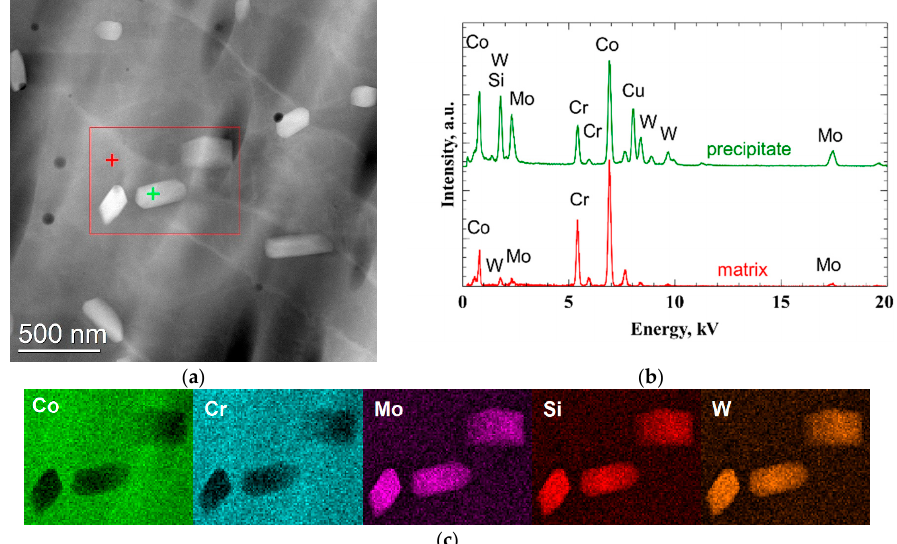
Figure 5. Chemical composition of the elongated shape precipitates. ( a ) STEM-HAADF image; ( b ) comparison of Energy Dispersive (EDS) spectra at the points indicated in (a ); ( c ) maps of Co, Cr, Mo, Si, and W distribution in the area marked in ( a ). Table 2. Experimental results (wt.%) of STEM-EDS analysis at the points indicated in Figure 4a. Element Co Cr Mo